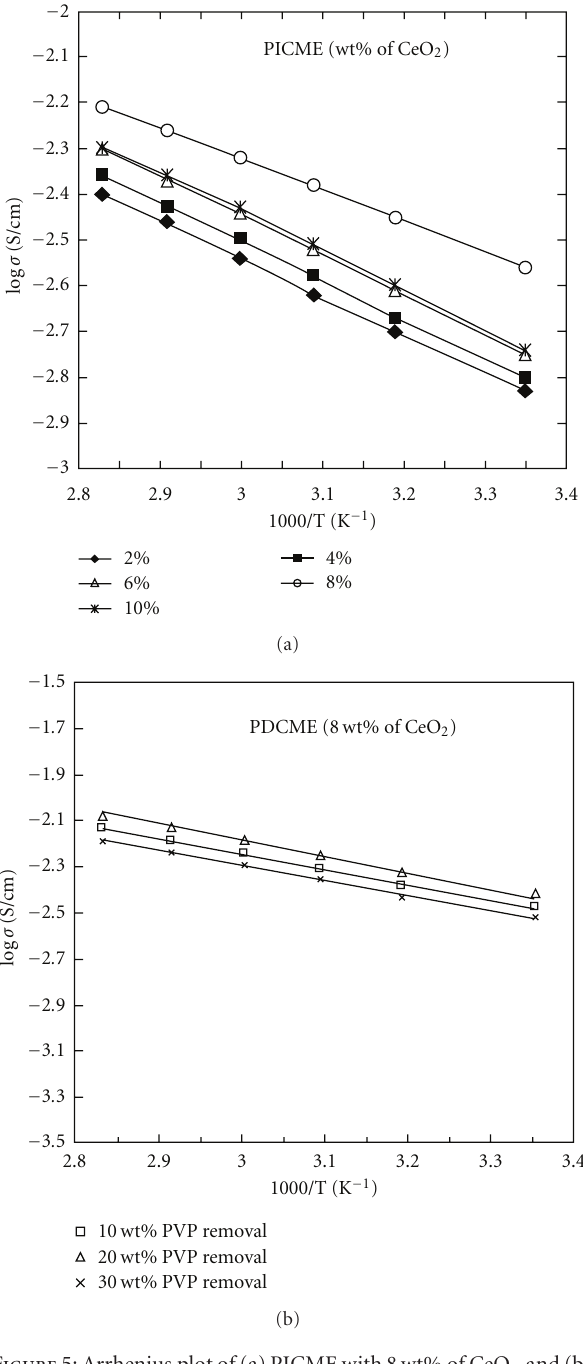
Figure 5: Arrhenius plot of (a) PICME with 8wt% of CeO 2 and (b) PDCME with the removal of di ff erent wt%